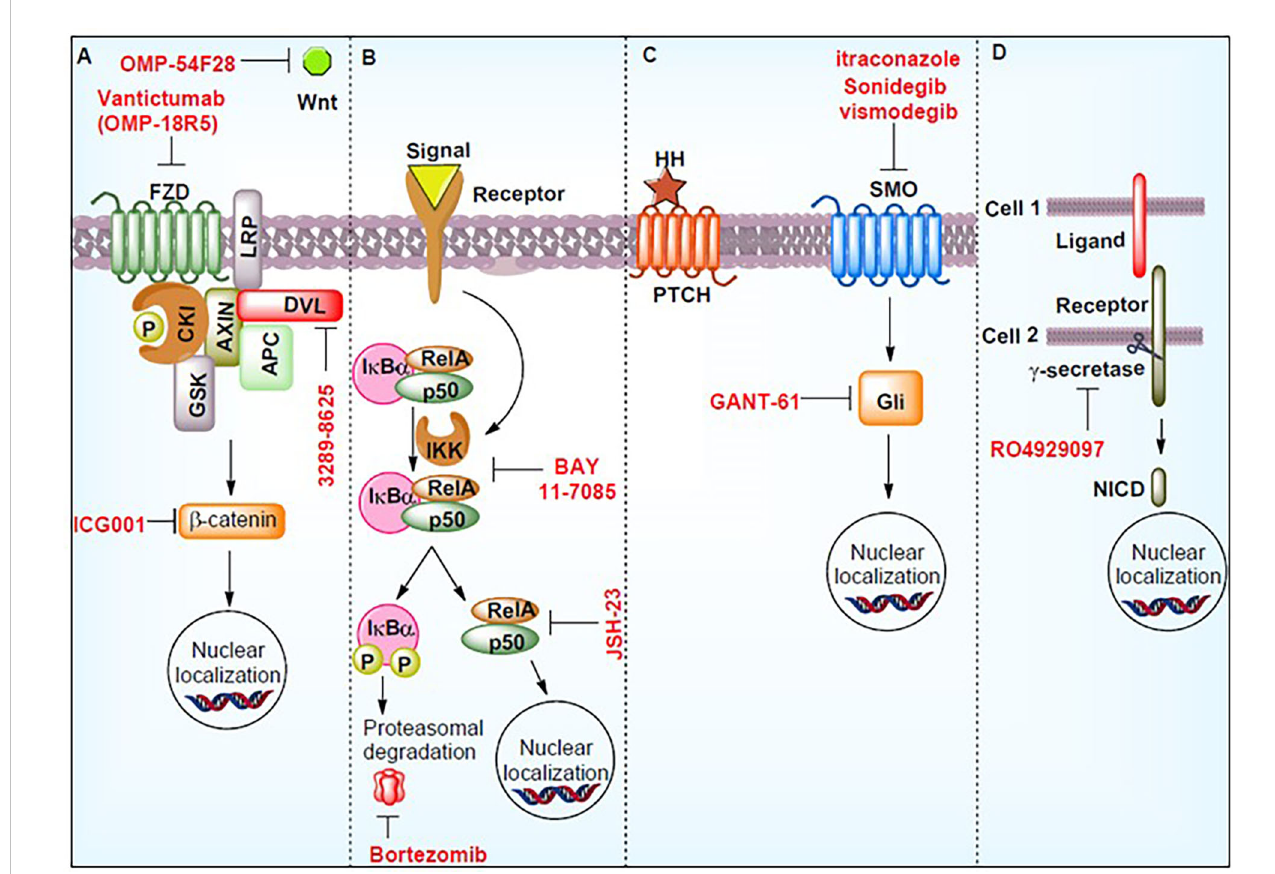
FIGURE 5 Signaling pathways controlling prostate cancer stem cells (PCSCs) and the work of inhibitors in suppressing these pathways. These molecules may act as potential therapeutics. The fi gure demonstrates the hedgehog signaling pathway (HH), notch intracellular domain (NICD), phosphorylation (P), smoothened (SMO), Wnt signaling pathways (Wnt), nuclear factor of kappa light polypeptide gene enhancer in B-cells inhibitor, alpha (IkB a ), RELA Proto- Oncogene (RelA), Frizzled (FZD), casein kinase I (CKI), axin (AXIN), APC regulator of the WNT signaling Pathway (APC), disheveled (DVL), glycogen synthase kinase (GSK), and inhibitor of nuclear factor kappa B kinase (IKK). Reproduced with permission from